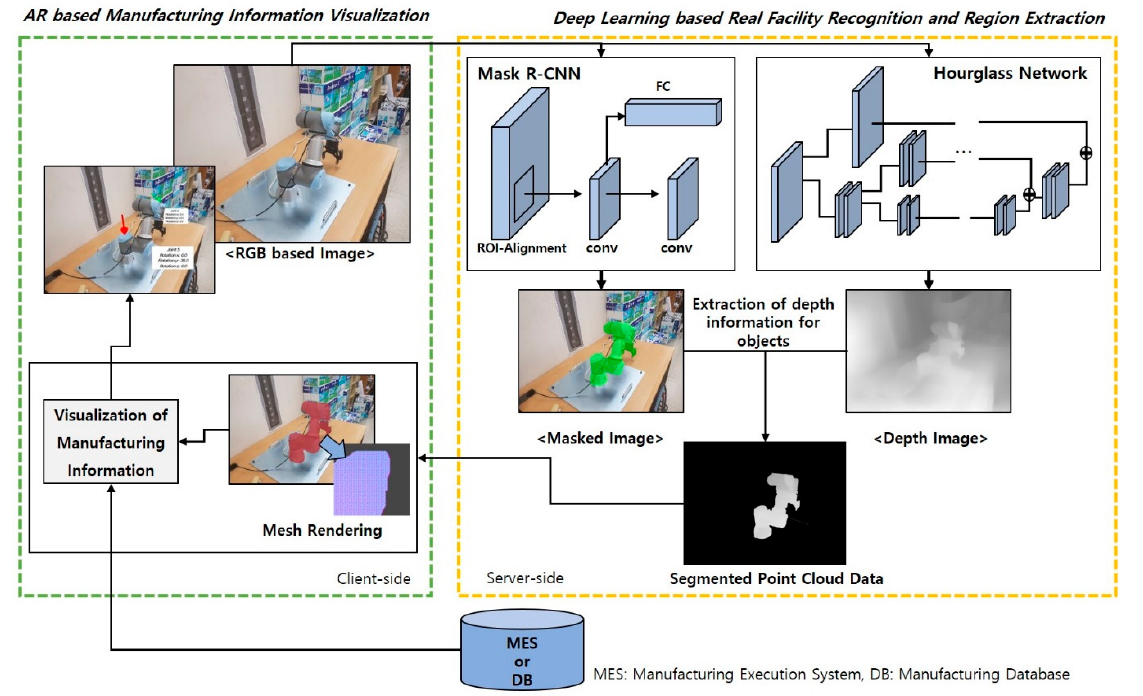
Figure 3. Framework of the proposed industrial AR.